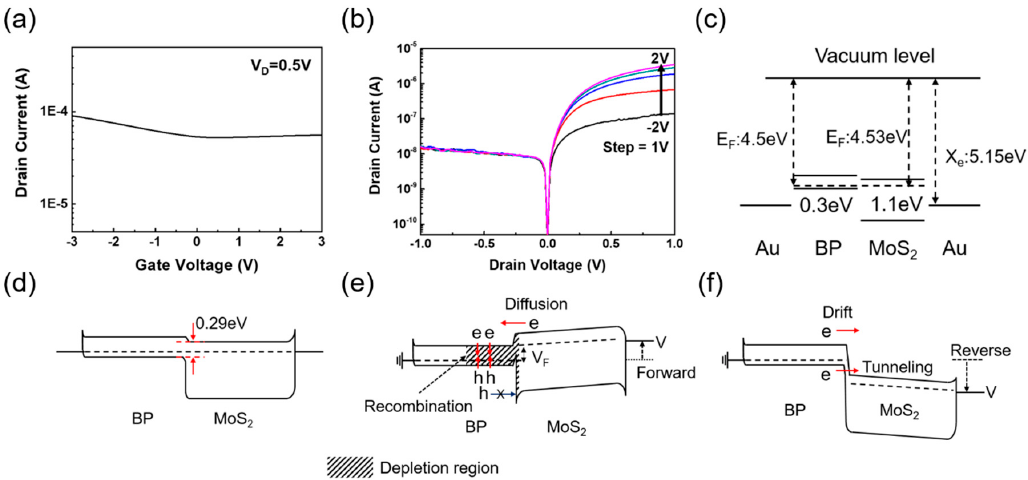
Figure 2. ( a ) Transfer characteristic of the thick-layer BP field-effect transistor (FET). ( b )